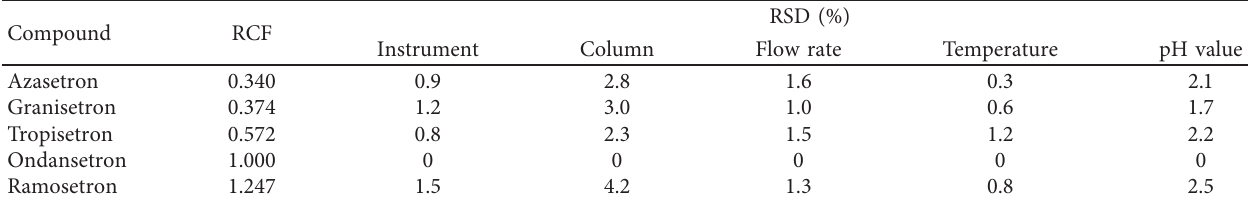
Table 6: Effects of HPLC column, flow rate, pH value of mobile phase, and column temperature upon RCF of the five 5-HT antagonists.